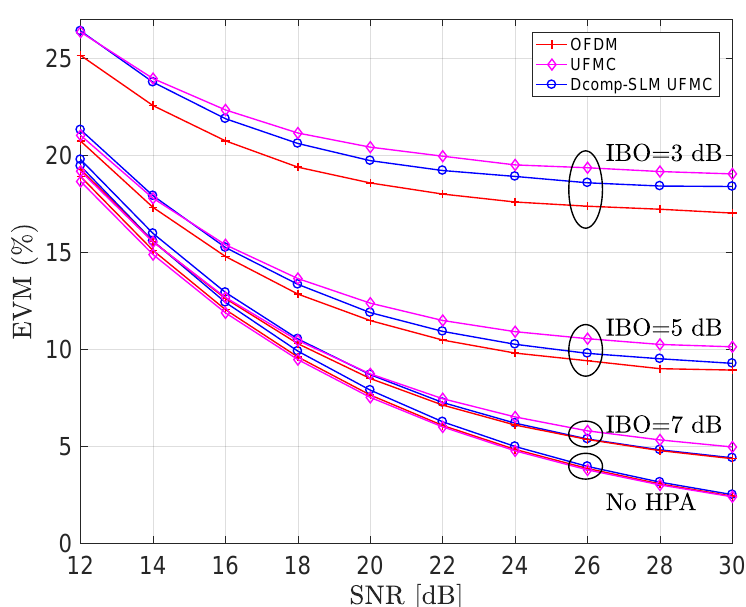
Figure 6. Error vector magnitude (EVM) performances of the proposed Dcomp-SLM comparing to the original OFDM and UFMC signals, in the presence of AWGN channel, for various IBO levels at N = 512 and U = 6 vectors.